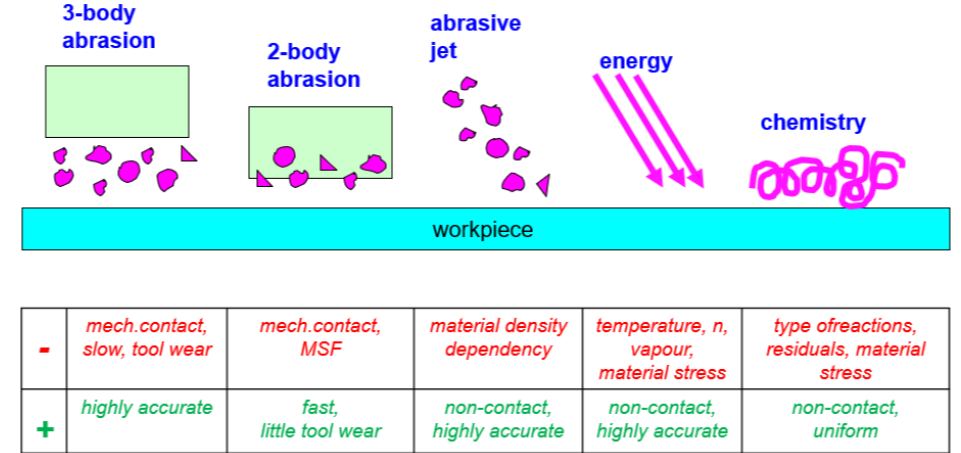
Fig.2. Optical polishing techniques are applied in five different wear approaches , each with its strong (“+”) and weak (“-“) characteristics in terms of generating optical